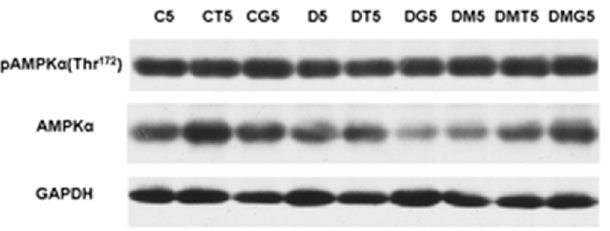
Figure 9. The immunoblots of α -AMPK and Thr 172 -phosphorylated α -AMPK as compared to the reference protein GAPDH in the testes of control and diabetic rats, and the effects of the MF and LH/hCG-R-agonists treatment. Table 7. The ratios of Thr 172 -phosphorylated α -AMPK/total α -AMPK, Thr 172 -phosphorylated α - AMPK/GAPDH and total α -AMPK/GAPDH in the testes of control and diabetic rats, and the effects of the treatment with MF and LH/hCG-R-agonists.